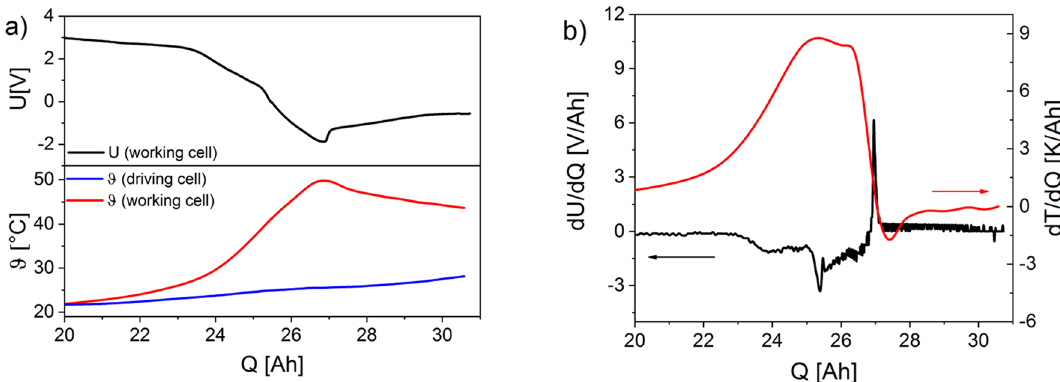
Figure 6. ( a ) Voltage curve and temperature curves during overdischarge of a series connection of the driving cell and the working cell at 58 mΩ. ( b ) Derivation of the voltage curve (black) and derivation of the corrected temperature curve (working cell,